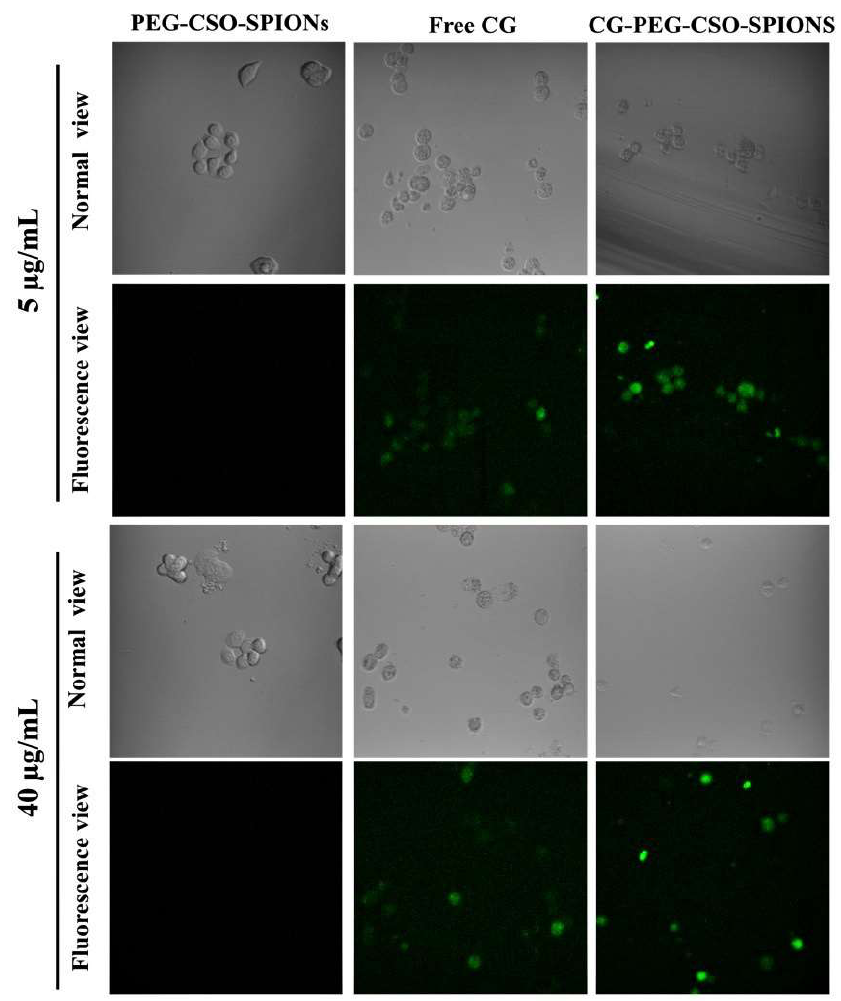
Figure 12. Representative CLSM images of CG uptake by HT-29 cells after 24 h of treatment with CG-PEG-CSO-SPIONs or free CG.